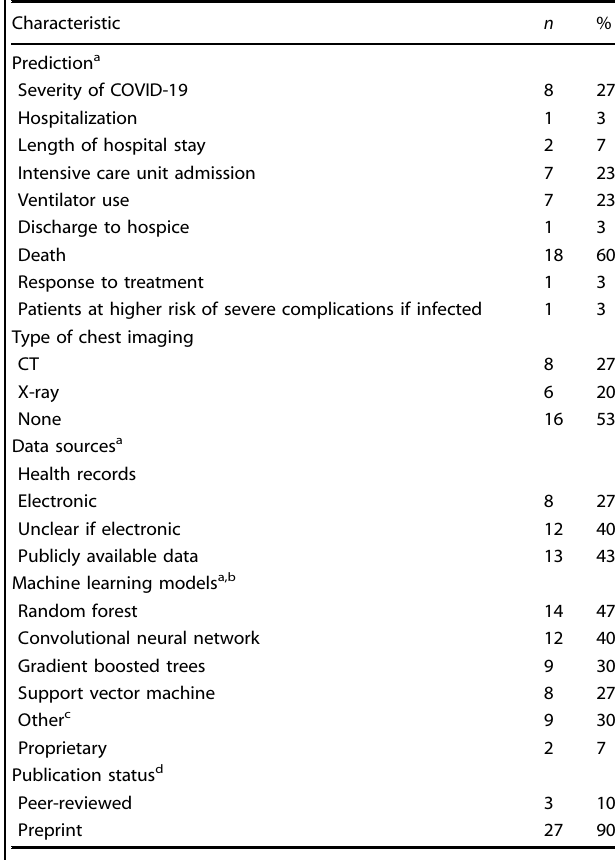
Table 5. Characteristics of studies that developed machine learning- based algorithms and tools to predict COVID-19-related deterioration ( n =